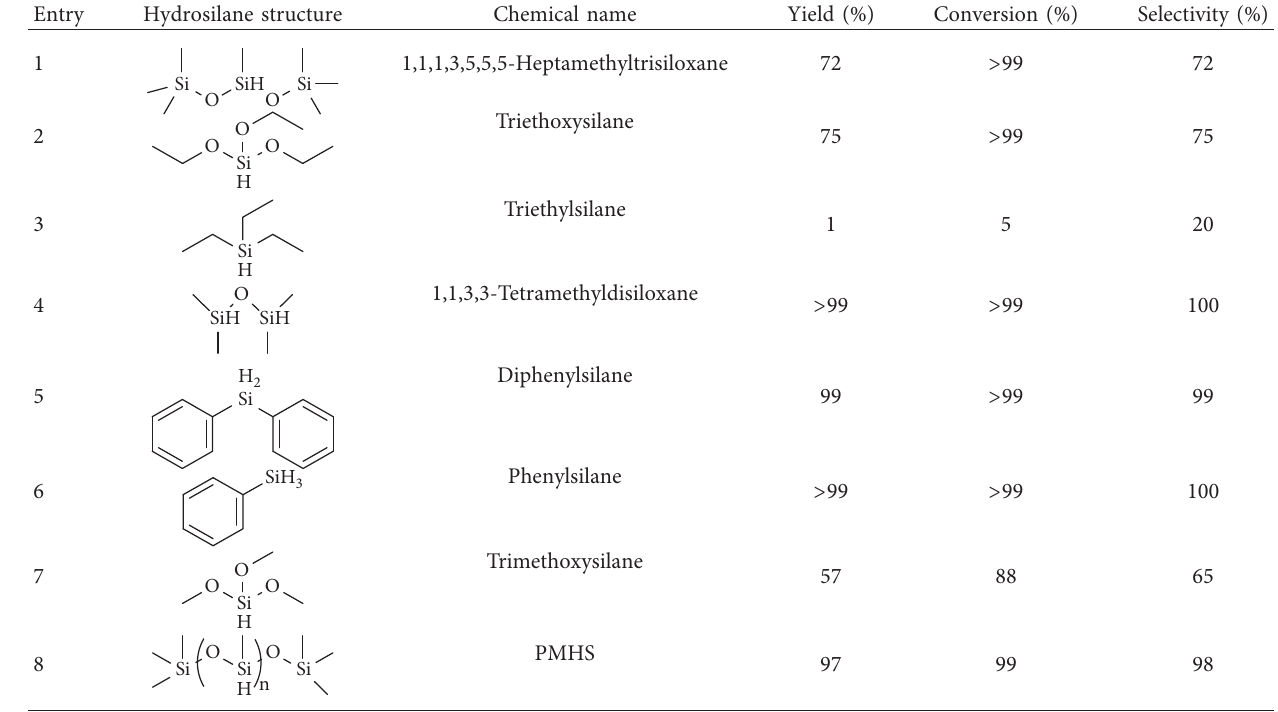
Table 3: Influence of hydrosilane type on the reduction of FUR to FFA.